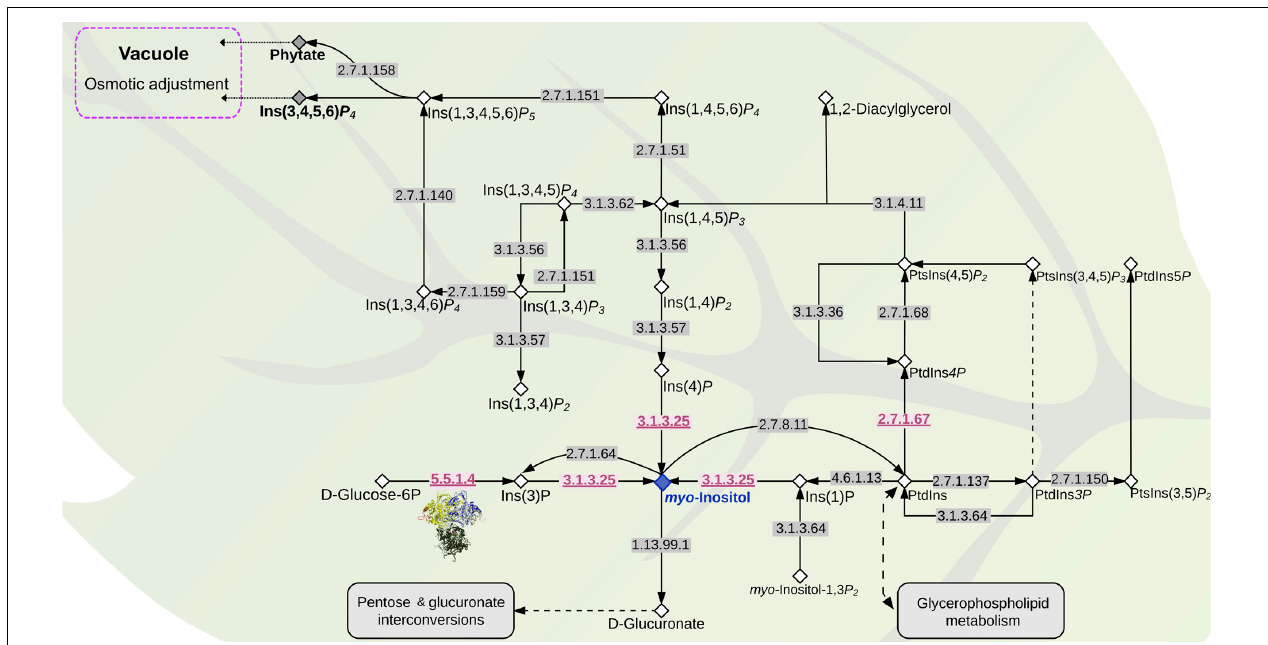
FIGURE 7 | The inositol metabolism pathway in S. pimpinellifolium and S. lycopersicum . The pathway was adapted from the KEGG inositol metabolism pathway (map00562- http://www.genome.jp/kegg/pathway/map/map00562.html). Compounds are represented with diamonds, myo -inositol is shown in a blue diamond whereas phytate and Ins(1,3,4,5) P 4 are represented by a gray diamond. Enzymes are represented with their EC numbers placed directly on arrows. Enzymes with gene copy numbers higher in S. pimpinellifolium than in S. lycopersicum are underlined and colored in red ( Supplementary Table S18 ). Compound abbreviations were taken from the ChEBI database (Hastings et al., 2013): Ins(1)P: Inositol 1-phosphate; PtdIns: Phosphatidyl-1D- myo -inositol; PtdIns3 P : 1-Phosphatidyl-1D- myo -Inositol-3 P ; PtsIns(3,5) P 2 : 1-phosphatidyl-1D- myo -inositol 3,5-bisphosphate; PtdIns5 P : 1-phosphatidyl-1D- myo -inositol 5-phosphate; PtsIns(3,4,5) P 3 : 1-phosphatidyl-1D- myo -inositol 3,4,5-trisphosphate; PtsIns(4,5) P 2 : 1-phosphatidyl-1D- myo -inositol 4,5-bisphosphate; Ins(1,4,5) P 3 : 1D- myo -inositol 1,4,5-trisphosphate; Ins(1,3,4,5) P 4 : 1D- myo -inositol 1,3,4,5- P 4 ; Ins(1,4,5,6) P 4 : 1D- myo -inositol 1,3,4,5- P 4 ; Ins(1,3,4,5,6) P 5 : 1D- myo -inositol 1,3,4,5,6- P 5 .